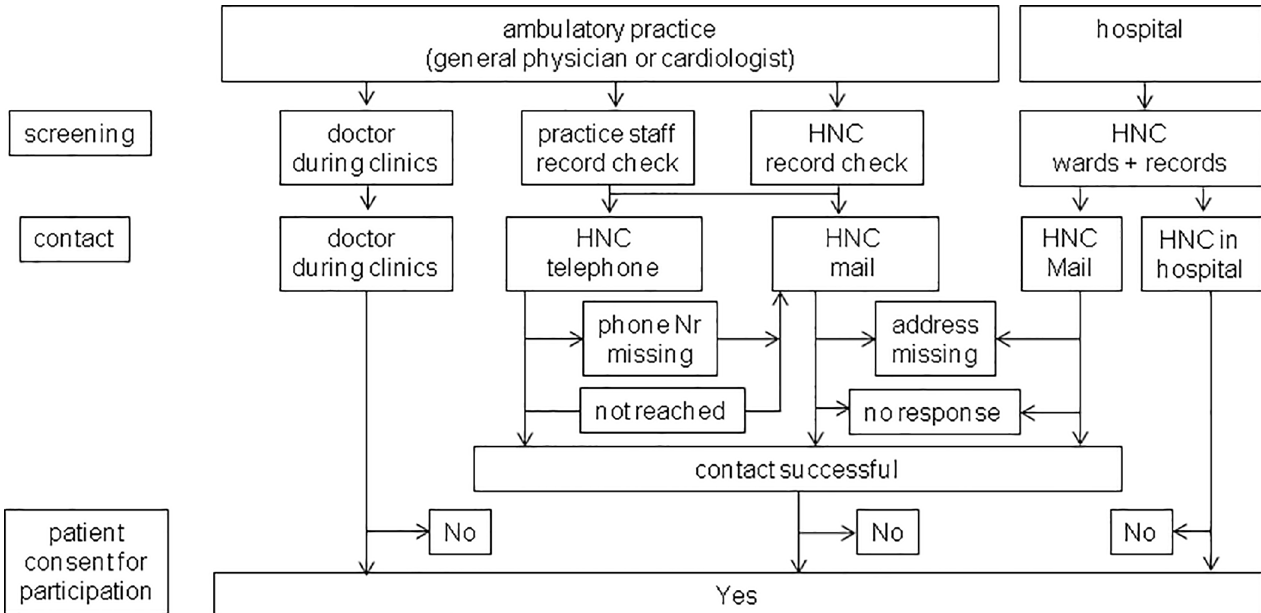
Fig 1. Pathways for screening and contacting patients for participation in the heart failure management programme. HNC indicatesstaff of the programme.